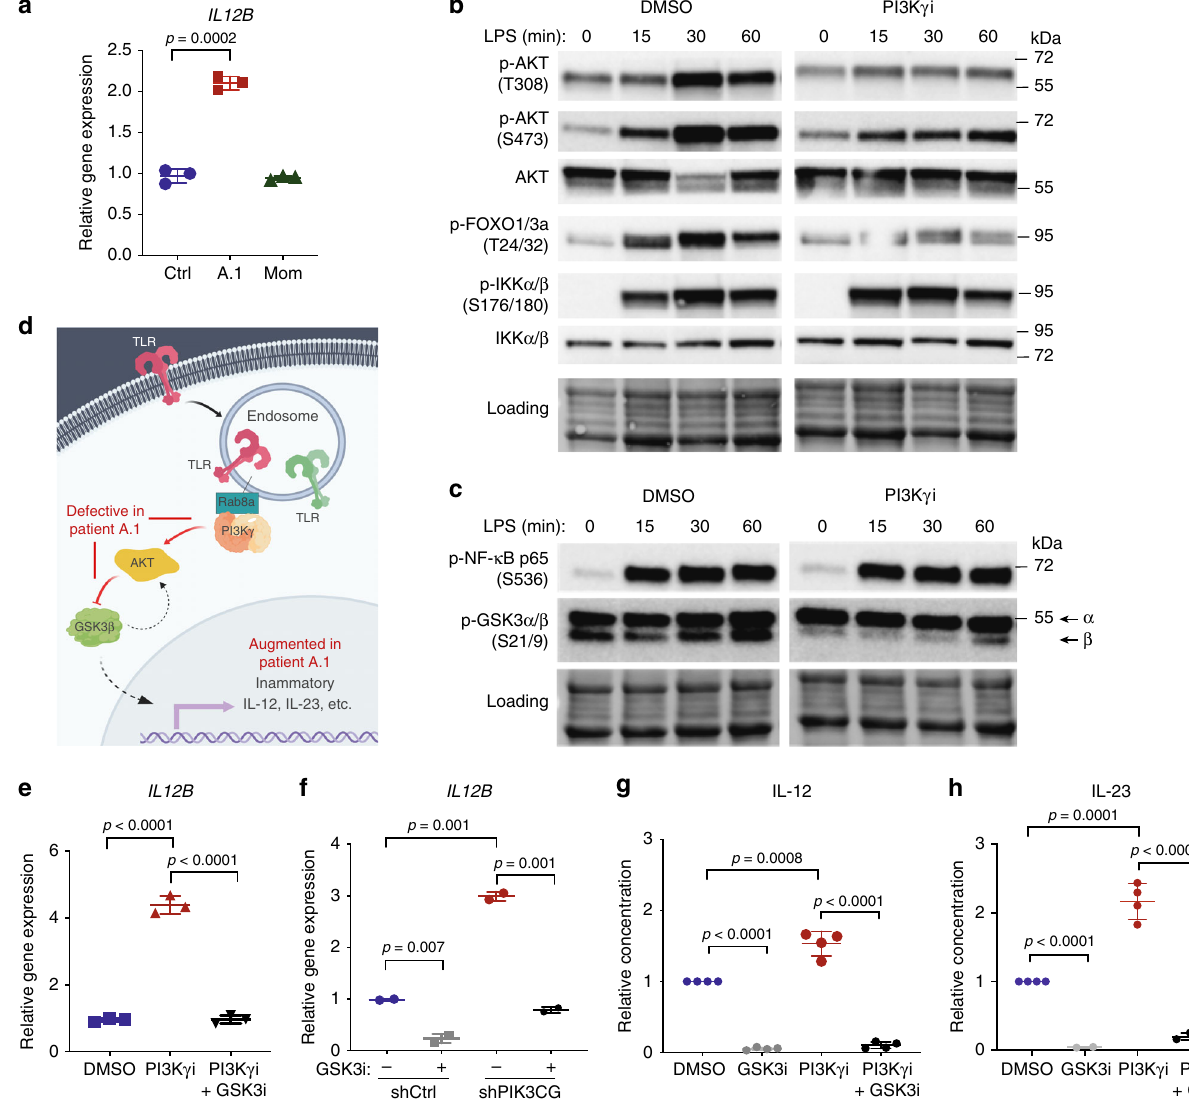
Fig. 3 Macrophages/monocytes overproduce in fl ammatory IL-12 and IL-23 in a GSK3 α / β -dependent manner upon TLR stimulation. a mRNA expression of IL12B normalized to GAPDH in monocyte-derived macrophages stimulated with IFN γ (20 ng/mL) and LPS (100 ng/mL) for 24 hr. Data are presented as mean ± SD, and are representative of two independent experiments in which one primary cell isolate for each group was run with three technical replicates. Statistical analysis was performed using a two-tailed unpaired T-test. b – c Immunoblotting for the indicated proteins in lysates from THP-1 monocytes stimulated with LPS (100 ng/mL) and treated with the PI3K γ inhibitor IPI-549 (1 μ M) or DMSO control. Equal protein loading was assessed using stain-free imaging (Bio-Rad). d Schematic of signaling pathway dysregulated in the absence of PI3K γ activity (created with BioRender.com). e mRNA expression of IL12B normalized to GAPDH in THP-1 macrophages treated with PI3K γ i IPI-549 (1 μ M) and GSK3i LY2090314 (20 nM) or DMSO control, as indicated, and stimulated with IFN γ (20 ng/mL) and LPS (100 ng/mL) for 16 h. Data are presented as mean ± SD, and are representative of three independent experiments, in which one primary cell isolate for each group was run with three technical replicates. Statistical analysis was performed using one-way ANOVA with Tukey ’ s multiple comparisons test. f mRNA expression of IL12B normalized to GAPDH and RPL37A in THP-1 macrophages expressing PIK3CG - targeted or control shRNA treated as in e and stimulated for 8 hr with IFN γ (20 ng/mL) and LPS (100 ng/mL). Data are presented as mean ± CI, and are representative of two independent experiments in which one primary cell isolate for each group was run with two technical replicates. Statistical analysis was performed using two-tailed unpaired T-test. g – h Cytokine protein concentration (relative to DMSO condition) in supernatant of healthy human donor monocyte-derived macrophages ( g ) or monocytes ( h ) treated with IPI-549 (500 nM) and/or GSK3 inhibitor LY2090314 (20 nM), as indicated, and stimulated with LPS (200 ng/mL) and IFN γ (5 – 35 ng/mL). Data are presented as mean ± SD and combined from 3 – 4 independent experiments in which one primary cell isolate for each group was run in duplicates. Statistical analysis was performed using two-tailed unpaired